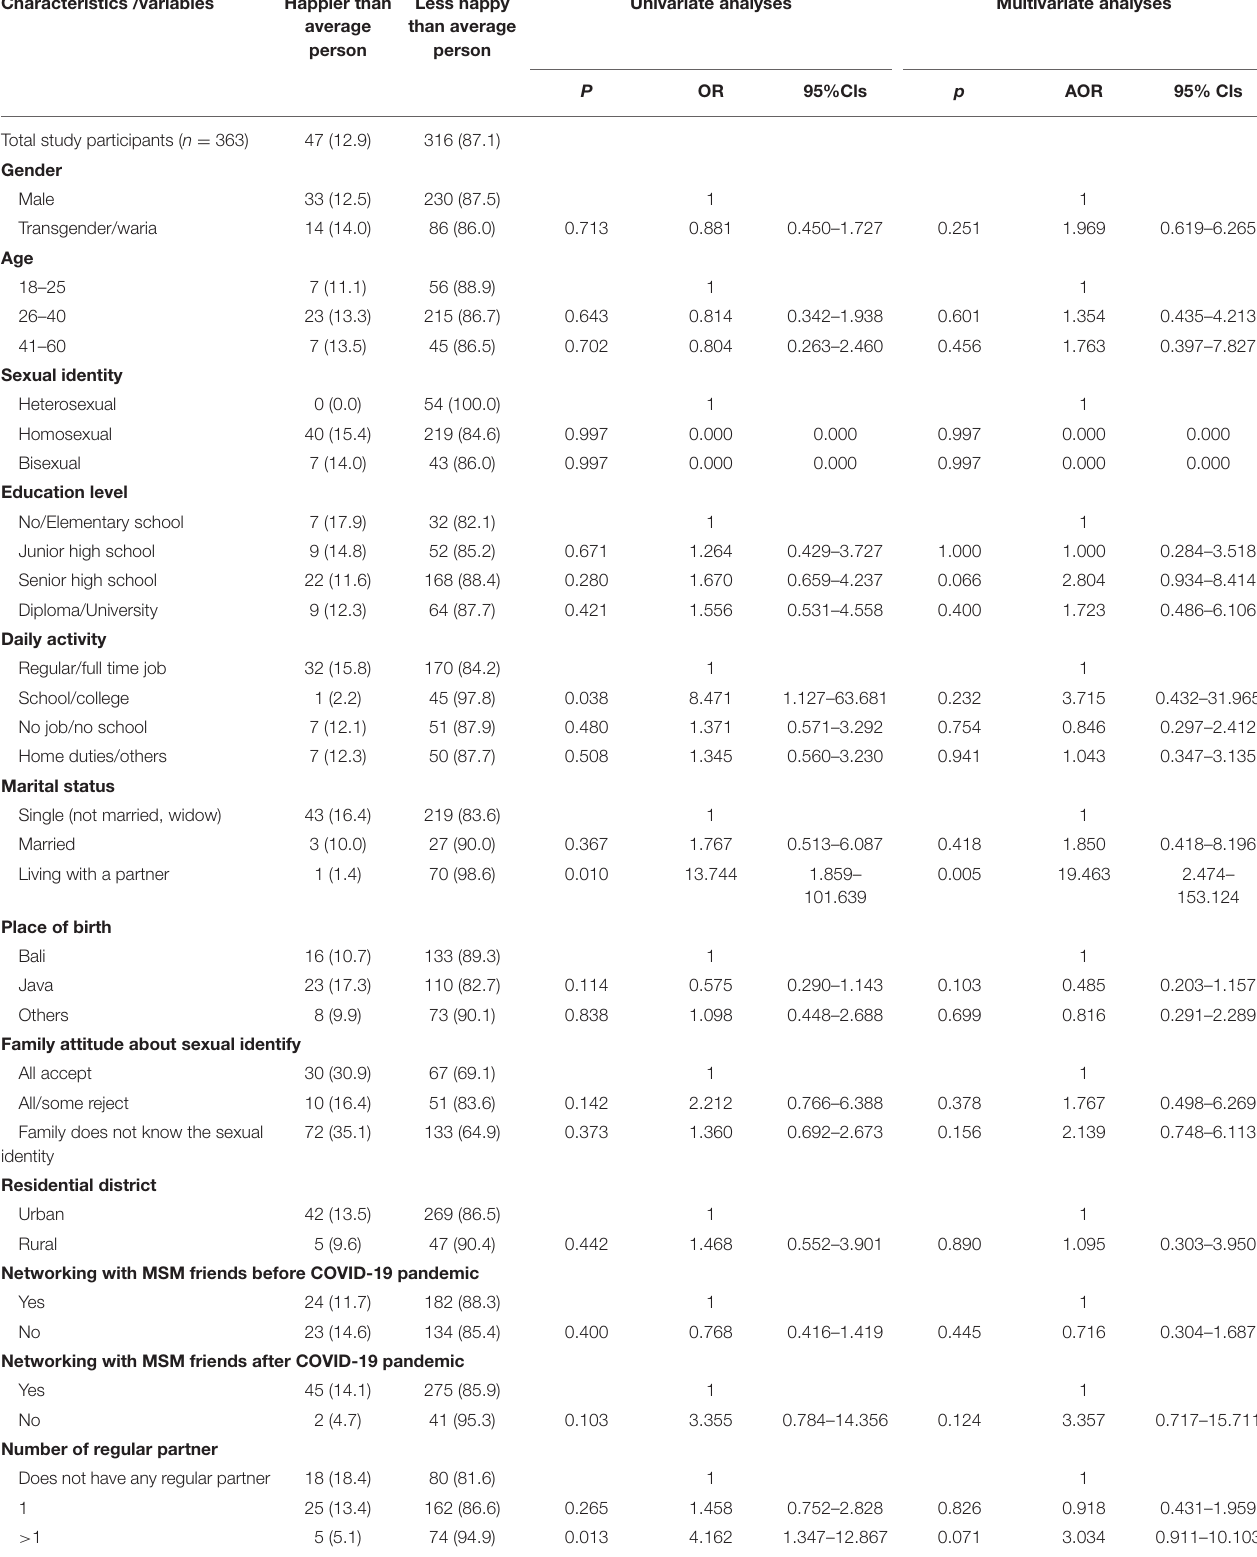
TABLE 5 | Factor associated with level of happiness among the study population (based on SHS score). Characteristics /variables Happier than